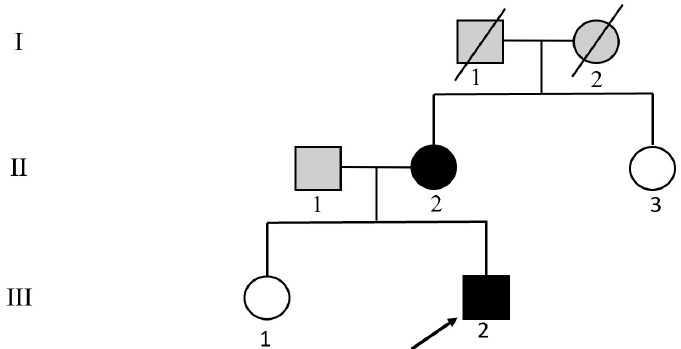
Figure 1. Family pedigree. Black-filled symbols, subjects carrying the identified RET c.1901G>A and SLC12A3 c.3070_3079delinsCAG mutations; empty symbols, subjects without identified mutations; gray-filled symbols, not sequenced; the black arrow indicates the